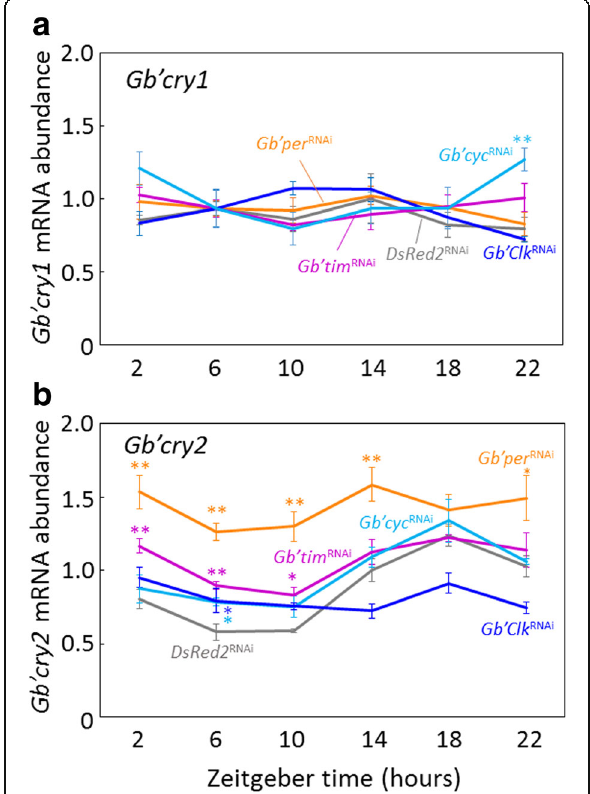
Fig. 7 Effects of RNAi of various clock genes on Gb ’ cry1 a and Gb ’ cry2 mRNA b in the cricket optic lobes. Adult male crickets ( Gryllus bimaculatus ) were treated with DsRed2 RNAi ( gray ), Gb ’ per RNAi ( orange ), Gb ’ tim RNAi ( purple ), Gb ’ Clk RNAi ( blue ), and Gb ’ cyc RNAi ( light blue ). The optic lobes were collected about 7 days after the dsRNA injection. The abundance of mRNA was measured by quantitative real-time RT- PCR with total RNA extracted from the optic lobes. The data collected from three and four independent experiments were averaged and plotted as mean±SEM for clock gene dsRNA-injected and ds DsRed2 - injected crickets, respectively. The abundance of Gb ’ rpl18a mRNA was used as an internal reference. The data for DsRed2 RNAi are replotted from Fig. 2. Asterisks indicate significant difference between DsRed2 RNAi crickets and those treated with clock gene dsRNAs: * P <0.05, ** P <0.01, Dunnett ’ s test. Note that Gb ’ cry1 mRNA levels were never affected by RNAi of clock genes except for cyc RNAi at ZT22, and that Gb ’ cry2 mRNA levels showed a rhythmic expression after Gb ’ tim or Gb ’ cyc dsRNA treatments, but became arrhythmic when treated with Gb ’ per or Gb ’ Clk dsRNA. For further explanations, see the